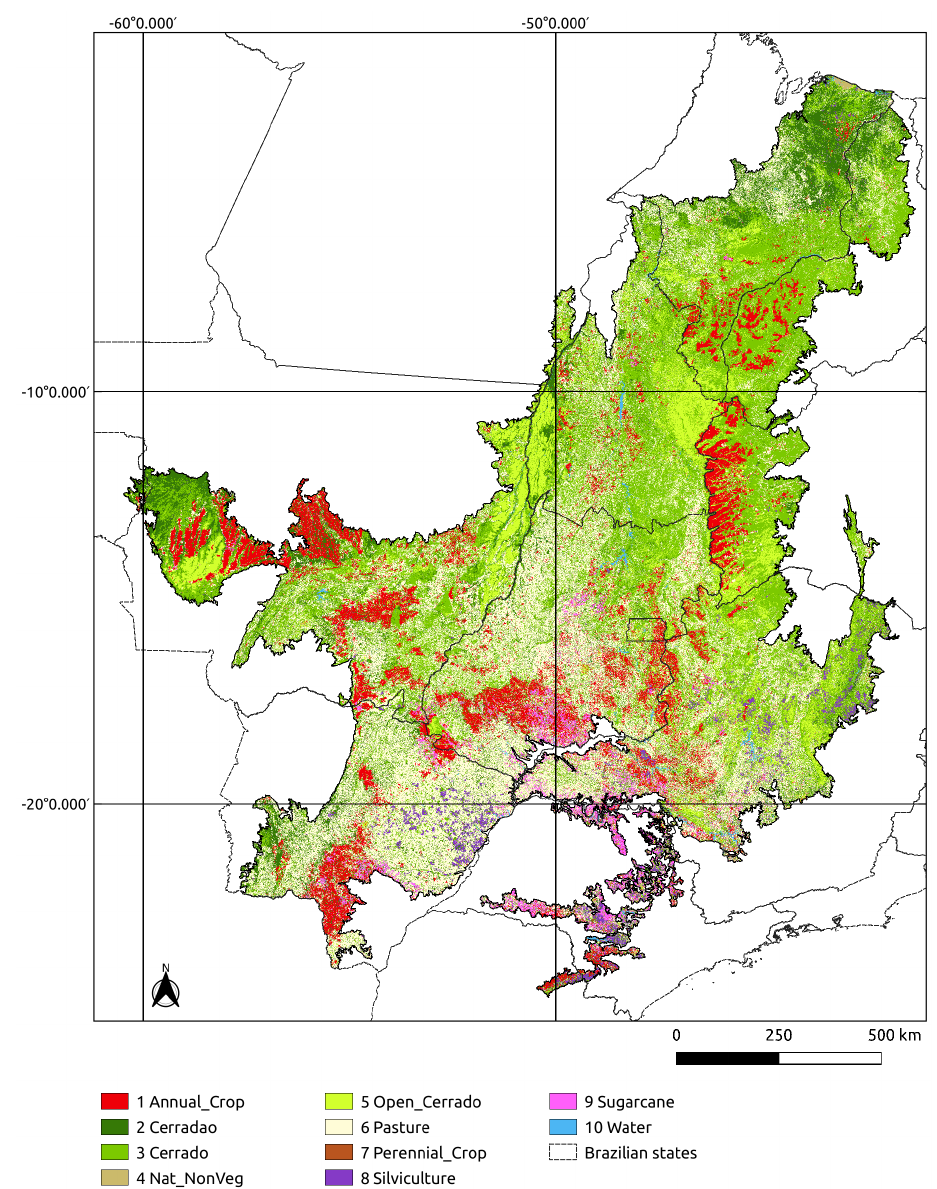
Figure 7. Cerrado land use and land cover map for 2018 (source: